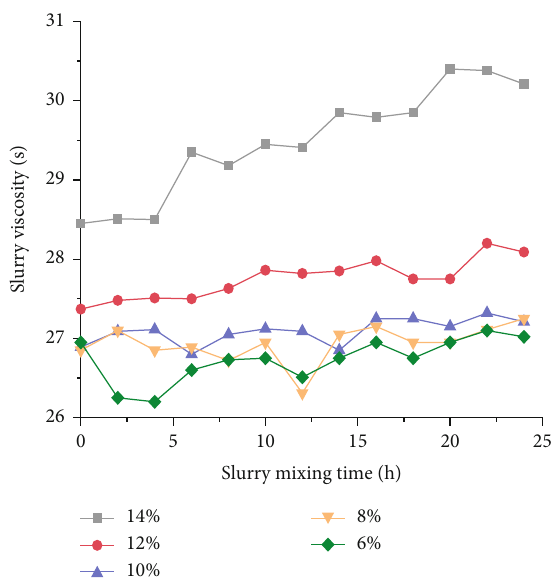
Figure 5: Time dependence curve of the slurry